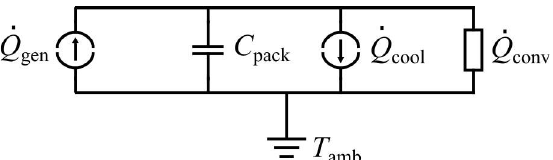
Figure 3. Equivalent circuit model of the thermal model of the battery